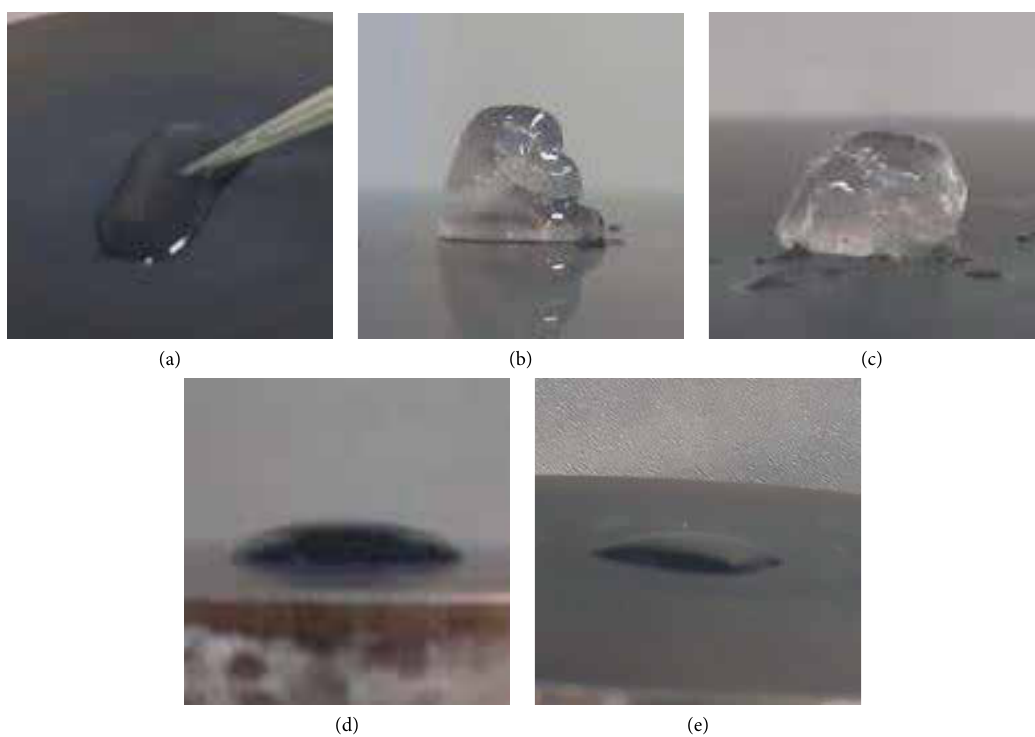
Figure 3: Macroscopic observation of the hydrogels on the plate during rheological analysis. (a–c) Mixture of HA-Plasmid1 and HA-Plasmid2. (a) Sample just after mixing was liquid. (b) Hydrogel was obtained after the first analysis. (c) Stiff hydrogel was obtained after the second analysis. (d) Native HA aqueous solution. (e) Hydrogel obtained after the third rheological analysis was treated with restriction enzyme. The sample changed into